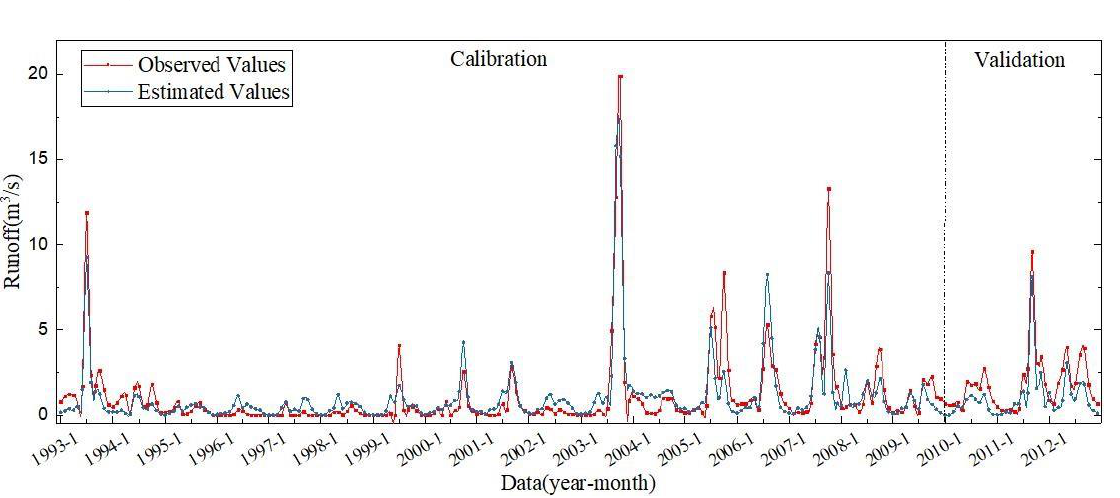
Figure 3. Comparison of observed monthly runoff and simulated monthly runoff in Tianshui